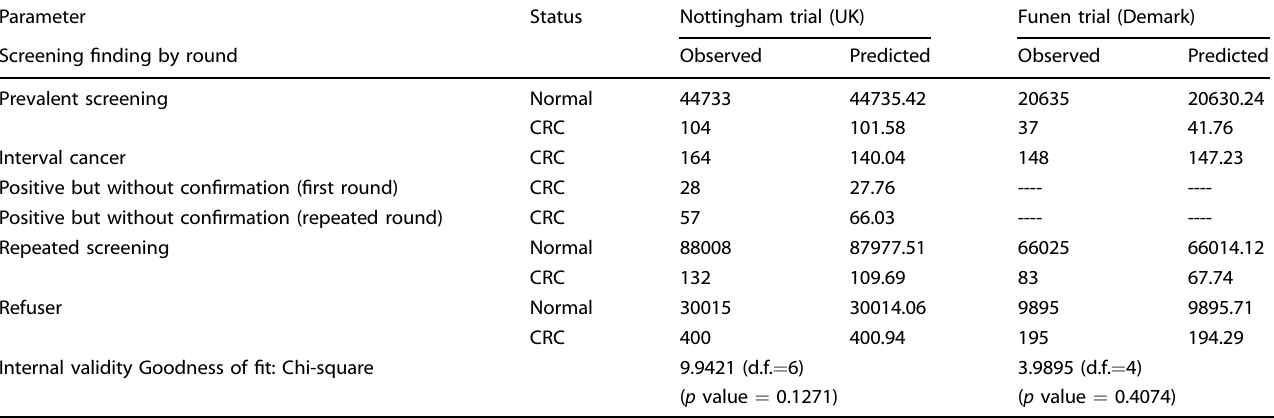
Table 3. Number of CRC by detection modes and model validity with the overdiagnosis-embedded disease natural history model of two gFOBT randomized controlled trials of CRC screening.